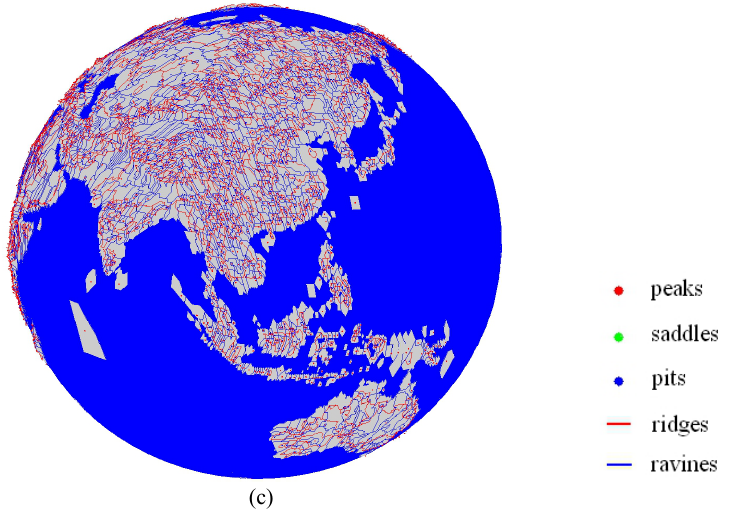
Figure 7. The multi-resolution GNG: (a) step=2000, (b) step=4000, (c)